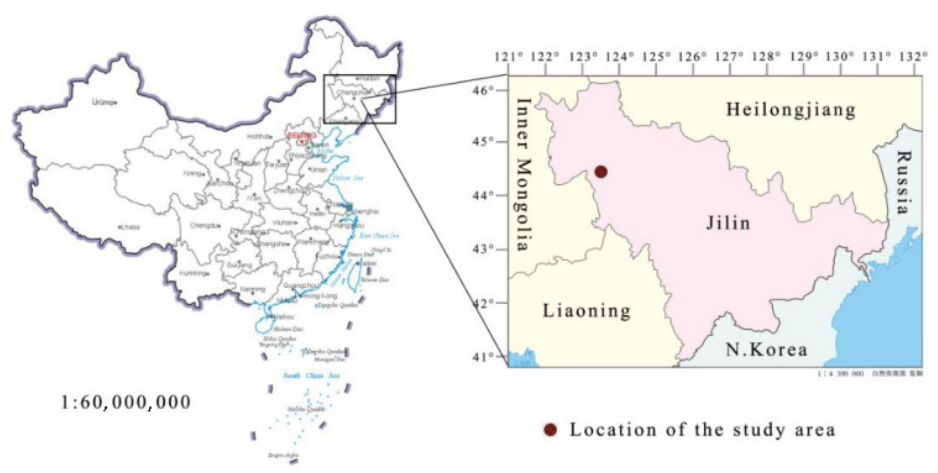
Figure 1. Location of the study area.